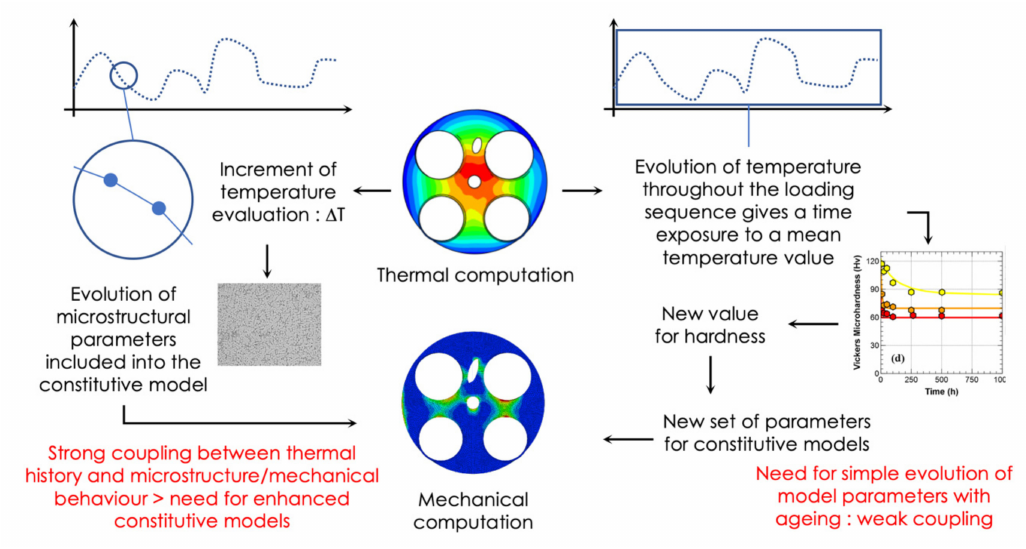
Figure 6. Coupling strategies: some